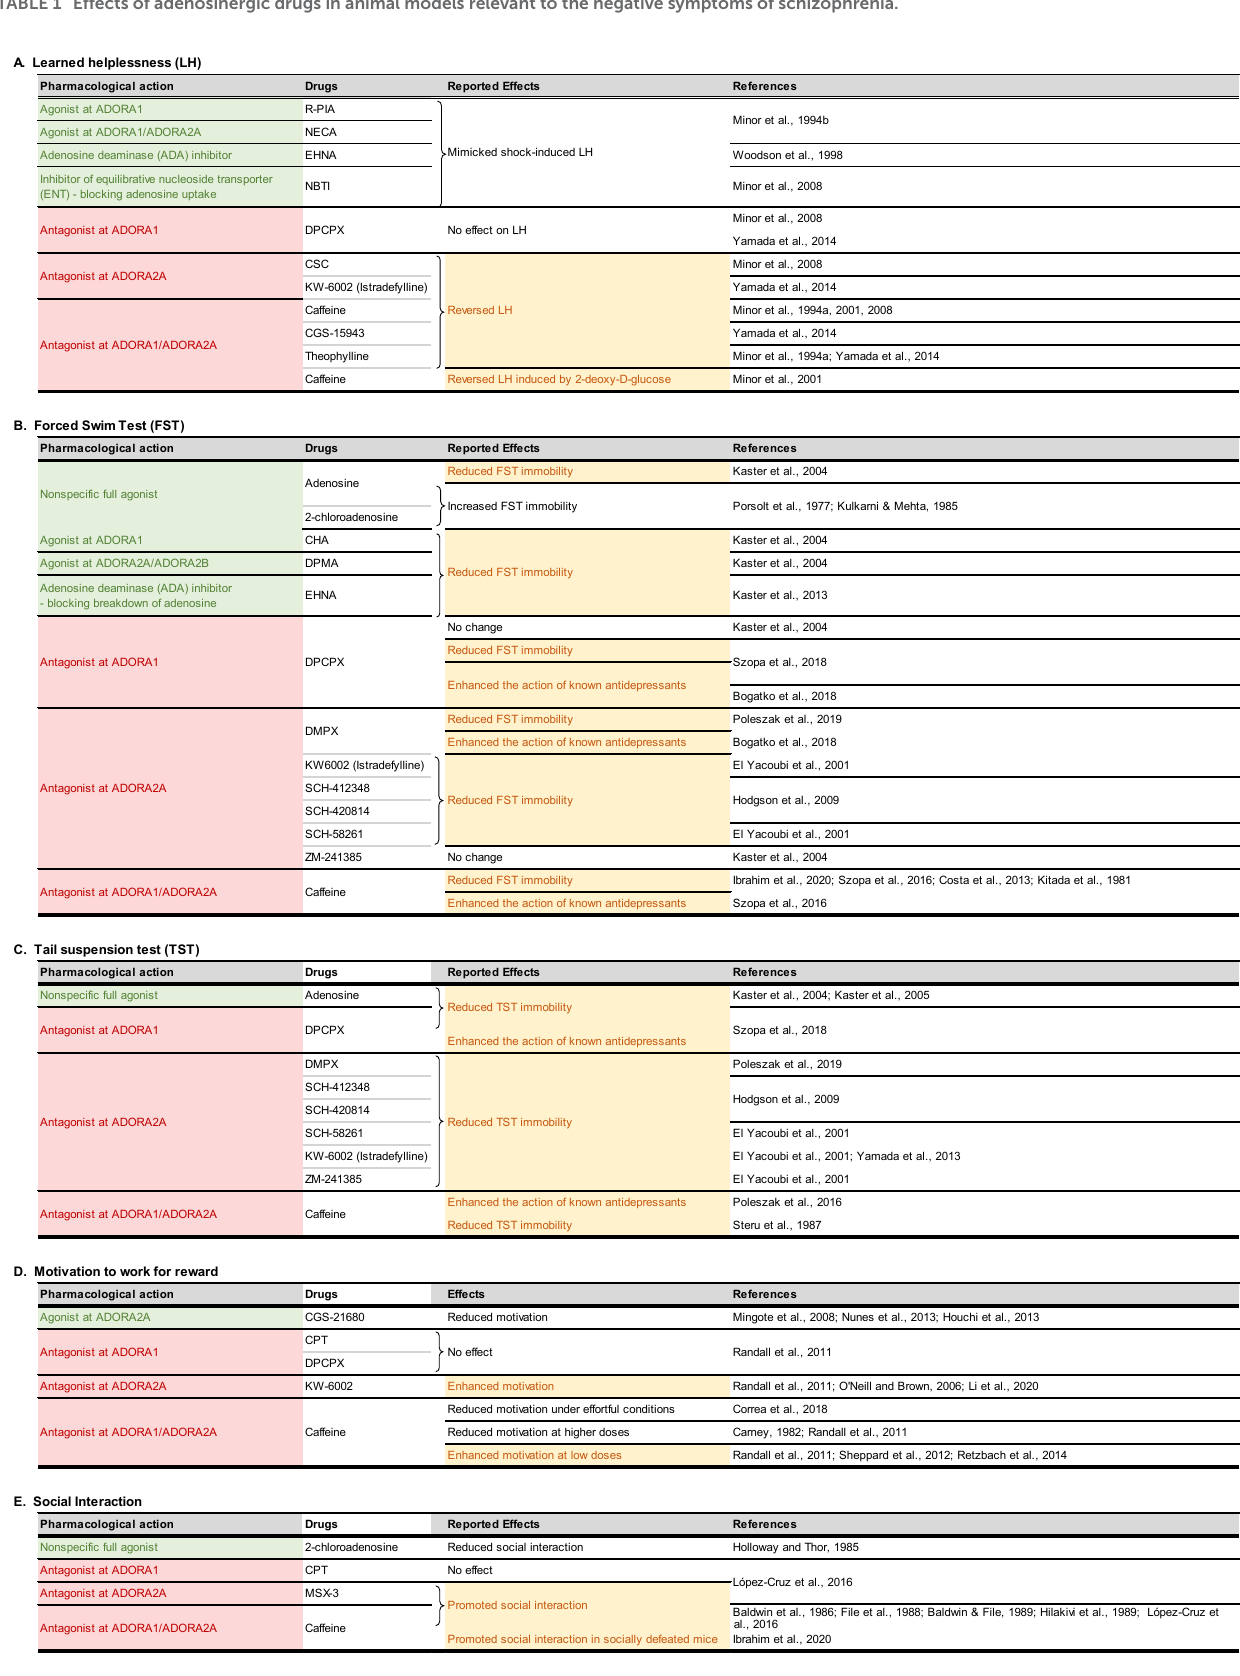
TABLE 1 Effects of adenosinergic drugs in animal models relevant to the negative symptoms of